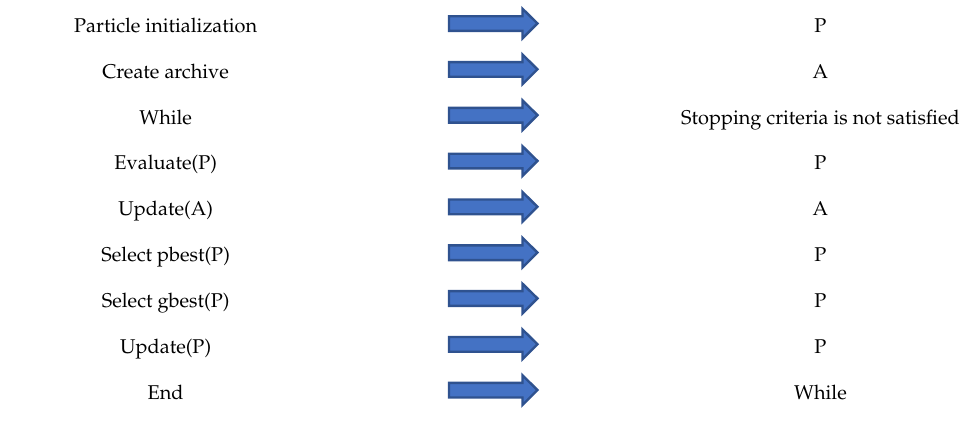
Table 1. Framework of the